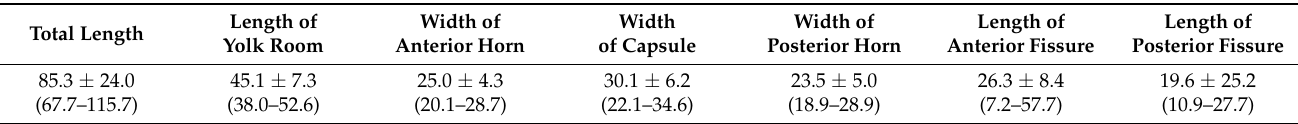
Table 3. Biometric comparison of various parts of the egg capsule of ocellate spot skate Okamejei kenojei . The numbers in parenthesis indicate the range of measurements from the 2019 specimens ( n = 96); unit: